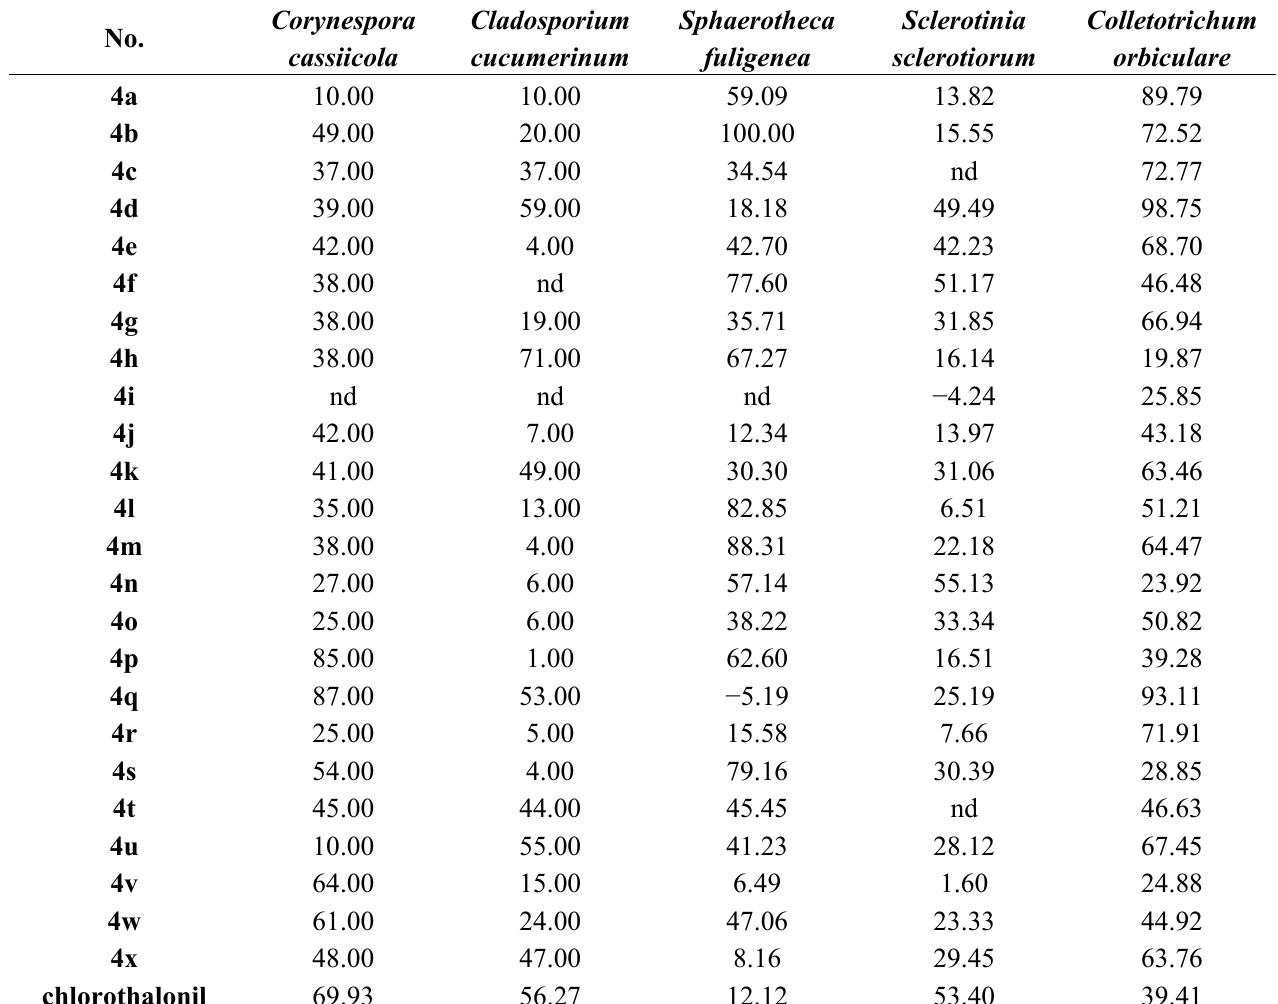
Table 1. Antifungal activity of title compounds (percent relative control efficacy) at 500 μ g/mL. No.